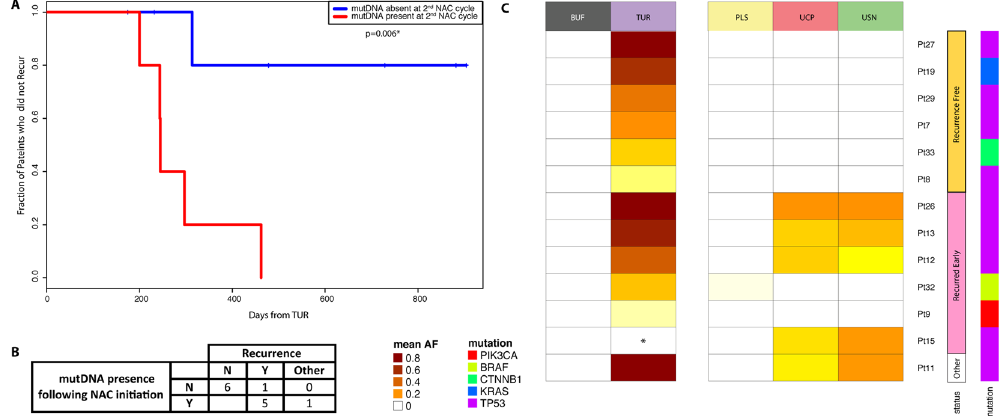
Figure 3. Presence of mutDNA at the 2 nd cycle of NAC predicts early recurrence in MIBC. ( A ) Kaplan-Meier curve depicting time to recurrence from initial TUR. We compared the rate of recurrence of patients with detectable mutDNA (red line) and undetectable mutDNA (blue line) in peripheral samples taken immediately prior to the 2 nd cycle of NAC (i.e. 2–3 weeks after the initiation of NAC). MutDNA was detected in 5/6 patients who recurred and in 0/6 recurrence free patients. Median time to recurrence in patients with detected mutDNA was 293 days while in patients with undetected mutDNA the recurrence rate was low. ( B ) Sensitivity and specificity for recurrence prediction. Overall sensitivity and specificity were 83.3% and 100% with positive predict value and negative predictive values of 100% and 85.7% respectively. One “other” patient was excluded from recurrence analysis due to post-operative death. ( C ) Heatmap comparing SNV maximum AF for each patient across all sample types and recurrence states at this time-point. Mutant allele fractions (mAFs) are represented by coloured cells ranging from white to scarlet as mAF increases (raw data in Supplementary Table 4). Patients are grouped by recurrence status. Generally, SNV mAFs are noticeably higher in USN and UCP as compared to PLS. There is a clear correlation between SNV mAF in peripheral samples and patient recurrence